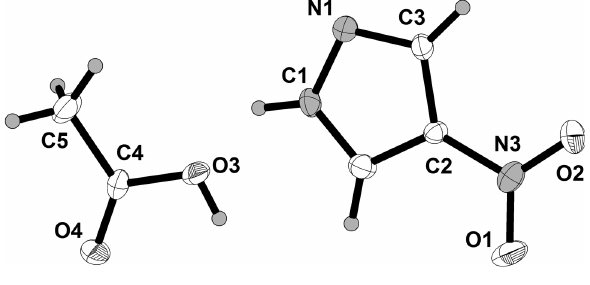
Table 1: Data collection and handling.